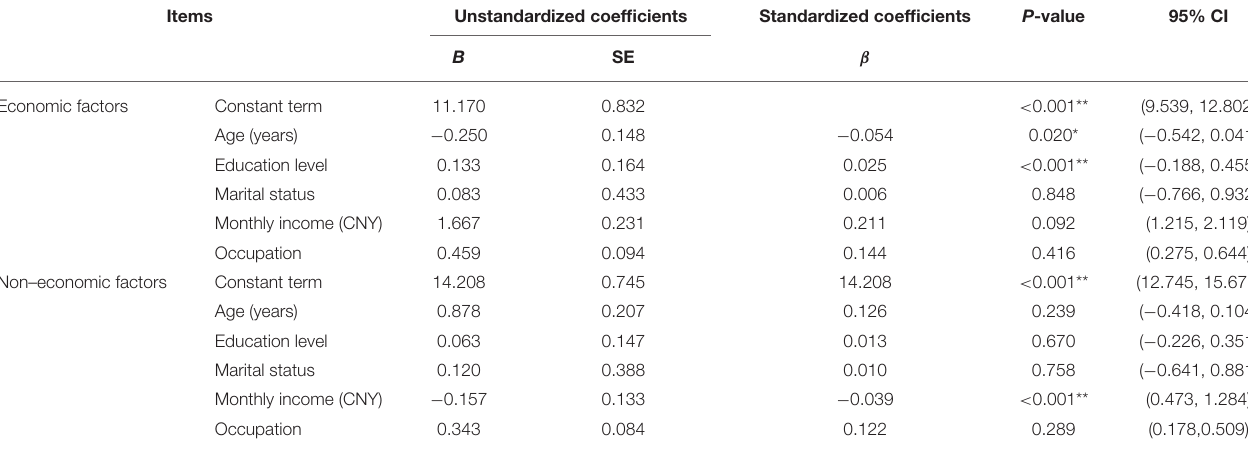
TABLE 4 | Multiple linear regression analysis on the preference degree of various motivation factors and related